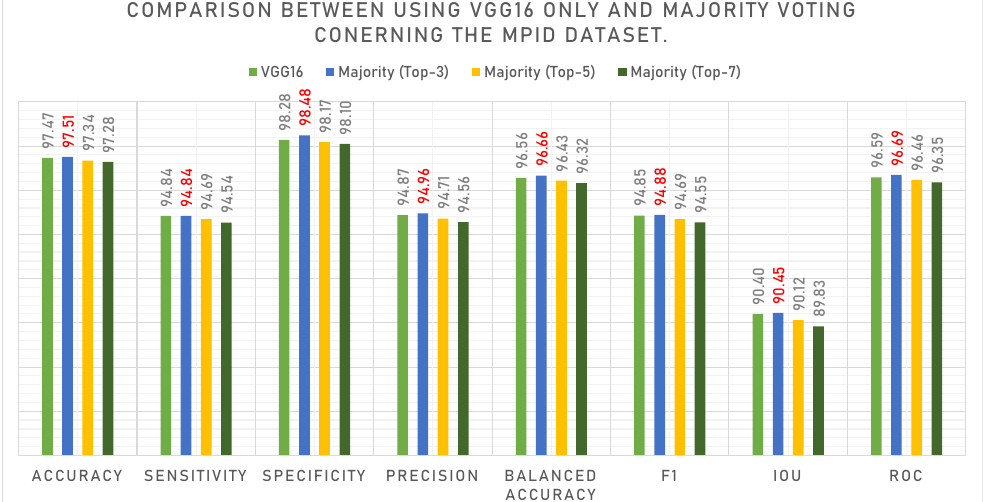
Figure 5. Graphical comparison between the results presented in Table 9.